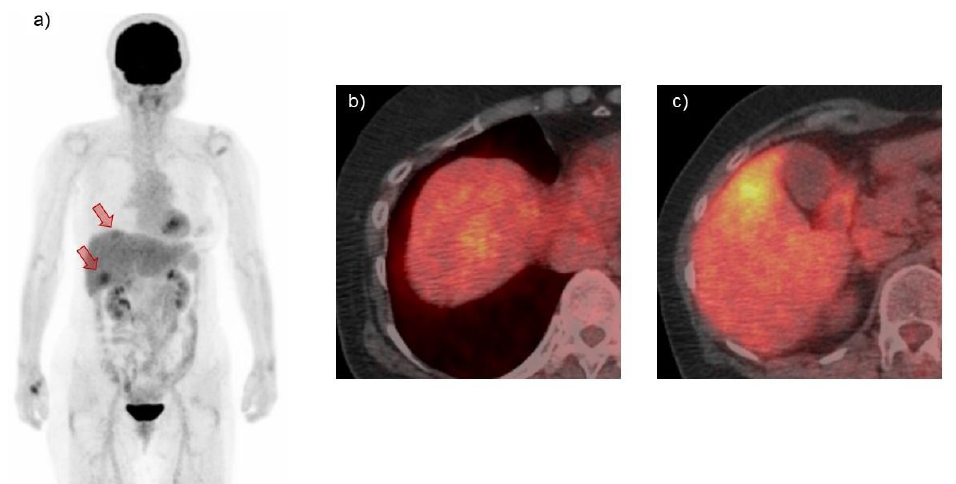
Figure 6. FDG-PET and computed tomography detected increased uptake in the liver tumor lesions (arrows), with no uptake in other organs ( a – c ).